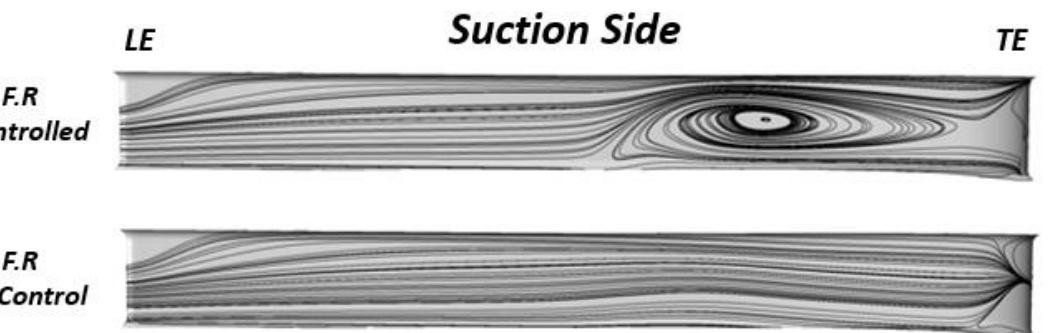
Figure 10. Surface streamline comparison of controlled and uncontrolled diffuser blade for stall mass flow.